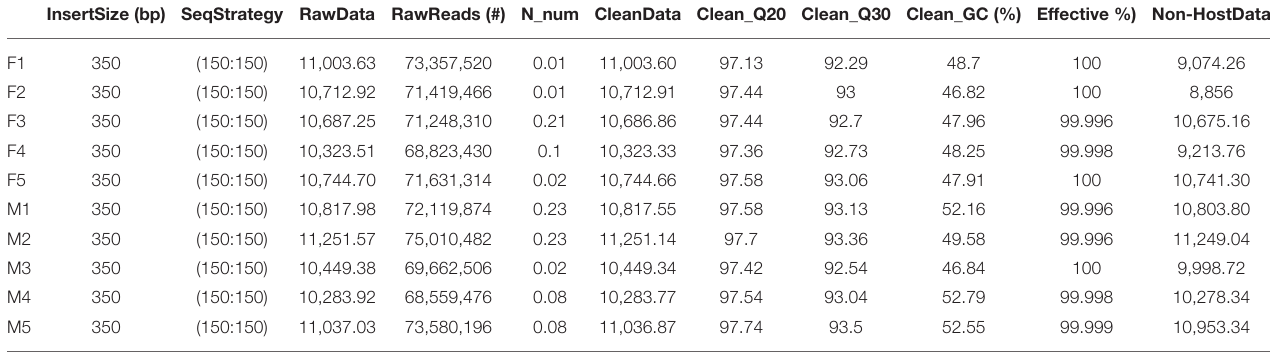
TABLE 1 | The statistics of the raw data, clean data and preprocessed data.